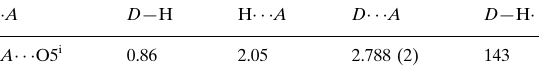
Hydrogen-bond geometry (A˚ , (cid:1) ). D —H (cid:2)(cid:2)(cid:2)